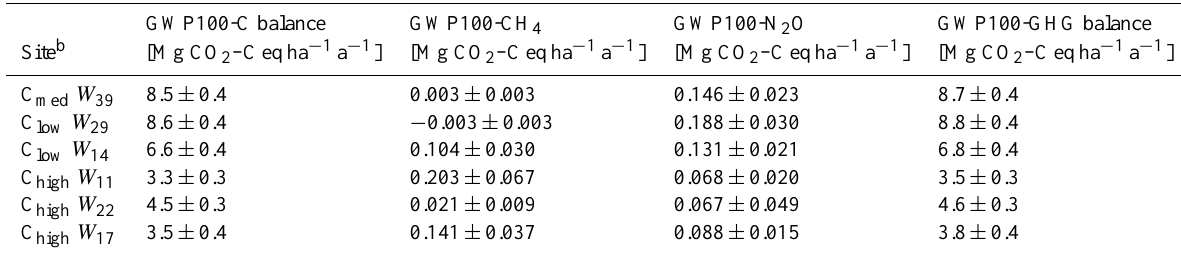
Table 4. Global warming potential for a time horizon of 100yr (GWP100) of Net C balance (NEE plus harvest), CH 4 and N 2 O and total GHG balance (annual flux ± uncertainty a ; Forster et al.,